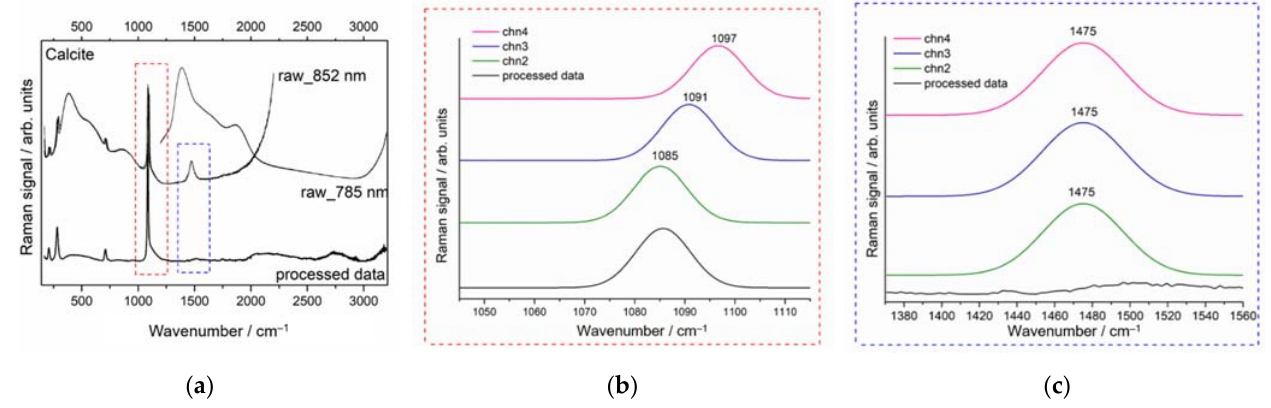
Figure 5. Portable Raman spectra of white substance acquired through glass attributable to ( a ) calcite (CaCO 3 ), the peak at 1085 cm − 1 assigned to ν s CO 3 2 − is marked with the red dashed rectangle while the band at 1475 cm − 1 arising from glass container with the blue dashed rectangle; ( b ) spectral zoom on 1085 cm − 1 shifted by 6 cm − 1 in channels 3 (blue solid line) and 4 (pink solid line); ( c ) spectral zoom on the band at 1475 cm − 1 remains constant in frequency in all three channels and is eliminated in SSE processed data (black solid line), providing for a background free spectrum.